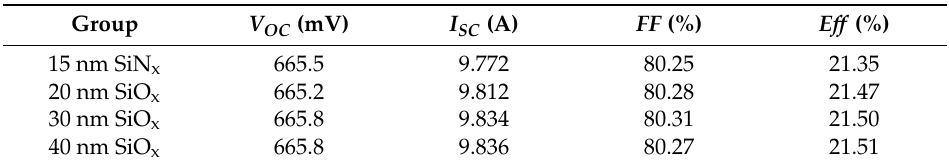
Table 2. The photovoltaic parameters of the monocrystalline silicon PERC solar cells fabricated with different third layers of antireflection coating. Each group contained about 100 solar cells, and the median values are listed.